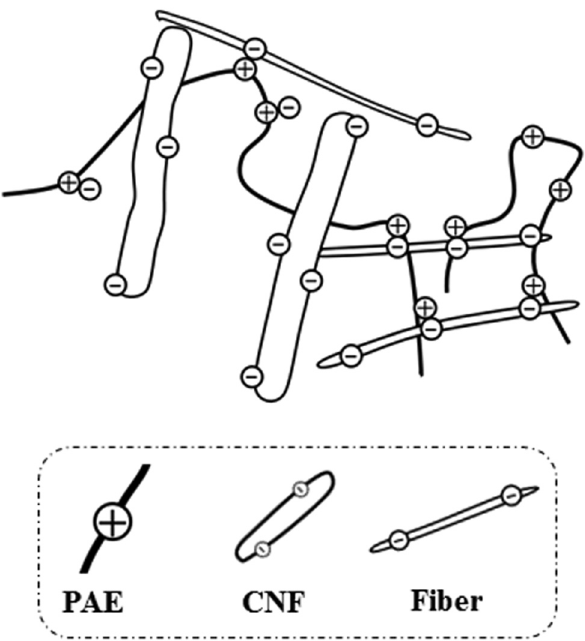
Figure 5: Schematic illustration on how CS – NS combination may interact with